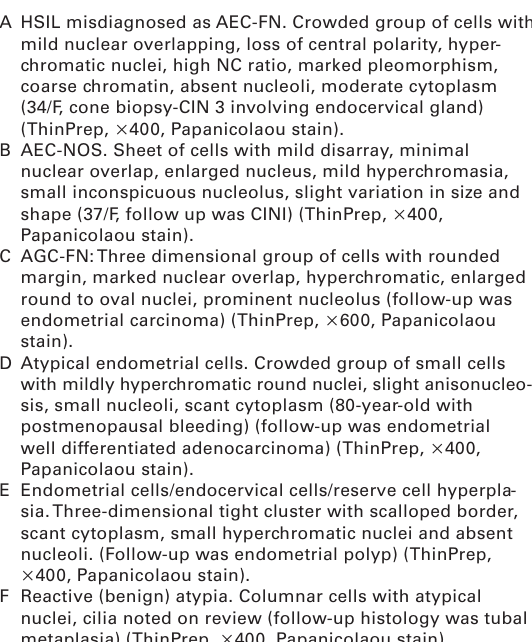
A HSIL misdiagnosed as AEC-FN. Crowded group of cells with mild nuclear overlapping, loss of central polarity, hyper- chromatic nuclei, high NC ratio, marked pleomorphism, coarse chromatin, absent nucleoli, moderate cytoplasm (34/F, cone biopsy-CIN 3 involving endocervical gland) (ThinPrep, (cid:2) 400, Papanicolaou stain). B AEC-NOS. Sheet of cells with mild disarray, minimal nuclear overlap, enlarged nucleus, mild hyperchromasia, small inconspicuous nucleolus, slight variation in size and shape (37/F, follow up was CINI) (ThinPrep, (cid:2) 400, Papanicolaou stain). C AGC-FN: Three dimensional group of cells with rounded margin, marked nuclear overlap, hyperchromatic, enlarged round to oval nuclei, prominent nucleolus (follow-up was endometrial carcinoma) (ThinPrep, (cid:2) 600, Papanicolaou stain). D Atypical endometrial cells. Crowded group of small cells with mildly hyperchromatic round nuclei, slight anisonucleo- sis, small nucleoli, scant cytoplasm (80-year-old with postmenopausal bleeding) (follow-up was endometrial well differentiated adenocarcinoma) (ThinPrep, (cid:2) 400, Papanicolaou stain). E Endometrial cells/endocervical cells/reserve cell hyperpla- sia. Three-dimensional tight cluster with scalloped border, scant cytoplasm, small hyperchromatic nuclei and absent nucleoli. (Follow-up was endometrial polyp) (ThinPrep,